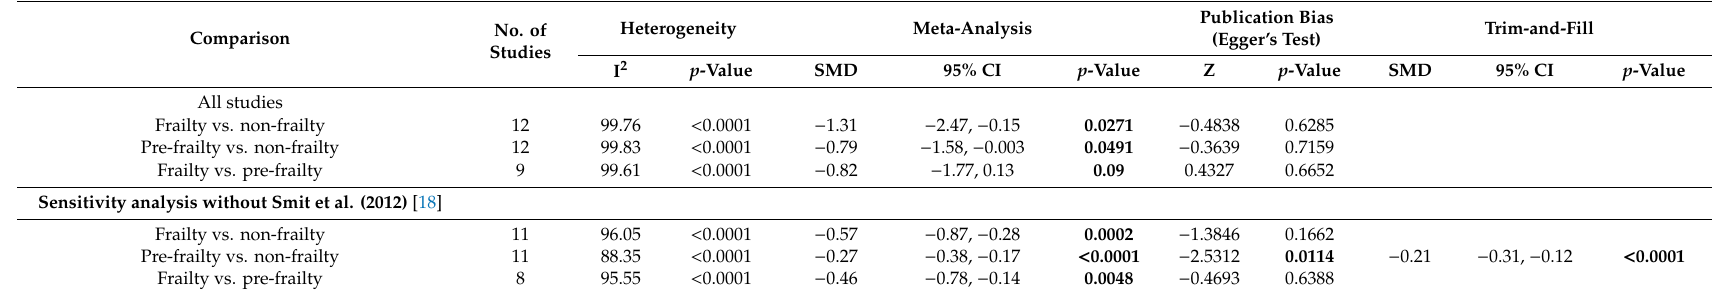
Table 2. Summary of meta-analyses comparing frailty groups with assessment of publication bias and sensitivity analysis. Statistically significant p -Values are indicated in